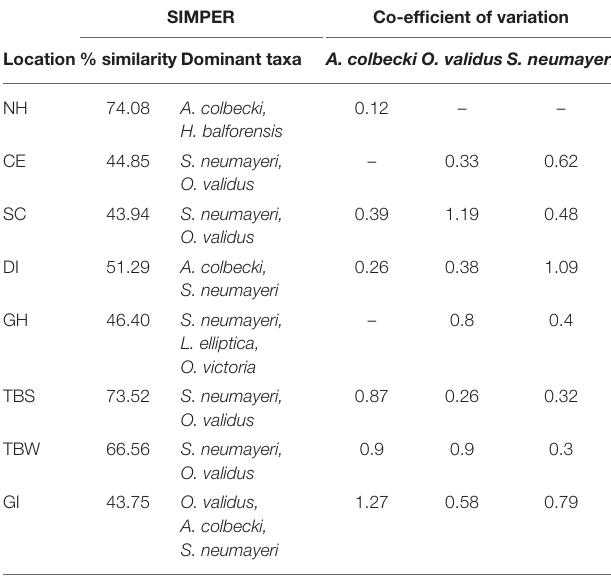
TABLE 4 | The percentage similarity in epifaunal community composition at each location, and the dominant taxa contributing to 90% of the variability (from SIMPER analysis of mean abundance m − 2 determined from video